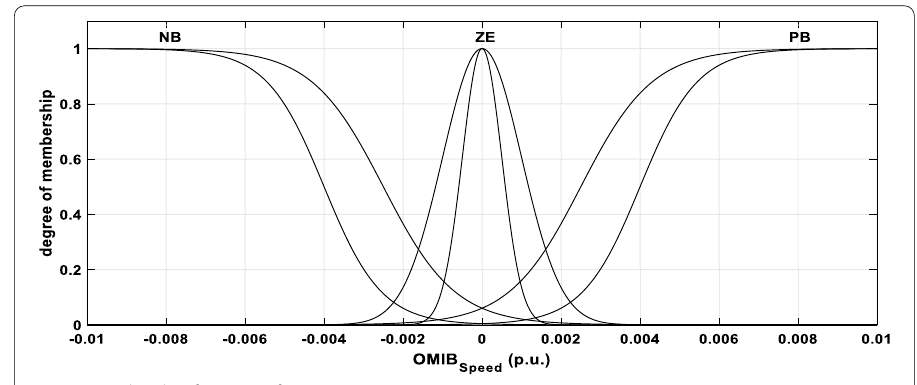
Fig. 4 Membership function of OMIB Speed